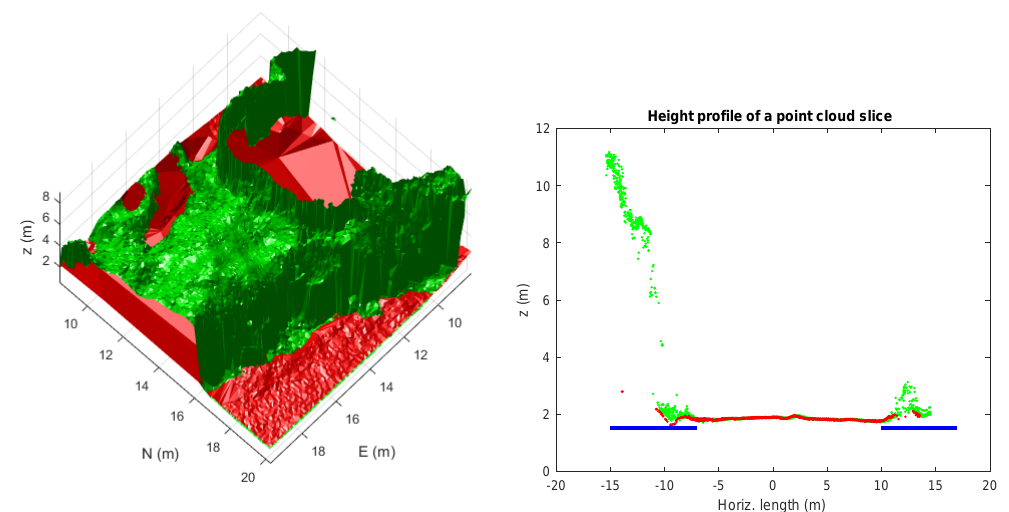
Figure 5. Left : The canopy detection is based on two separate SAF runs with different parameters to detect the canopy top surface (green) and the normal ground model (red). Right : A vertical slice of the point cloud depicted at the left. Blue vertical bars indicate where the extra thinning of the ground model is being applied. Note the ground model profile arising at the canopy front due to the lack of photogrammetric ray penetration.